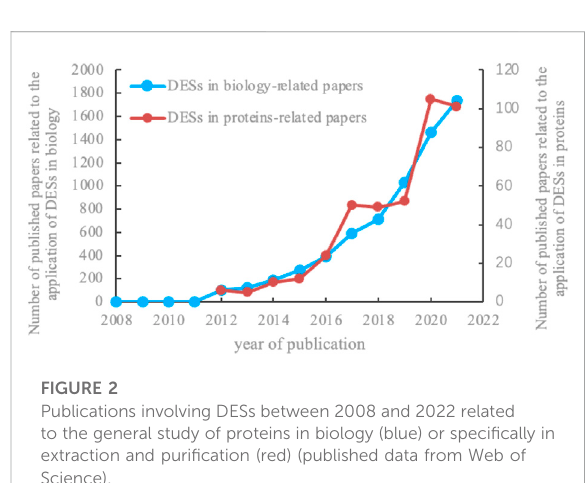
FIGURE 2 Publications involving DESs between 2008 and 2022 related to the general study of proteins in biology (blue) or speci fi cally in extraction and puri fi cation (red) (published data from Web of